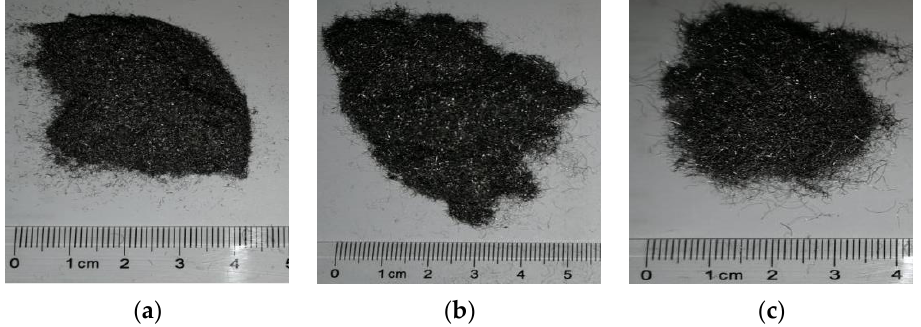
Figure 3. Macrographs of steel wool fiber. ( a ) 1 mm; ( b ) 3 mm; ( c ) 5 mm.